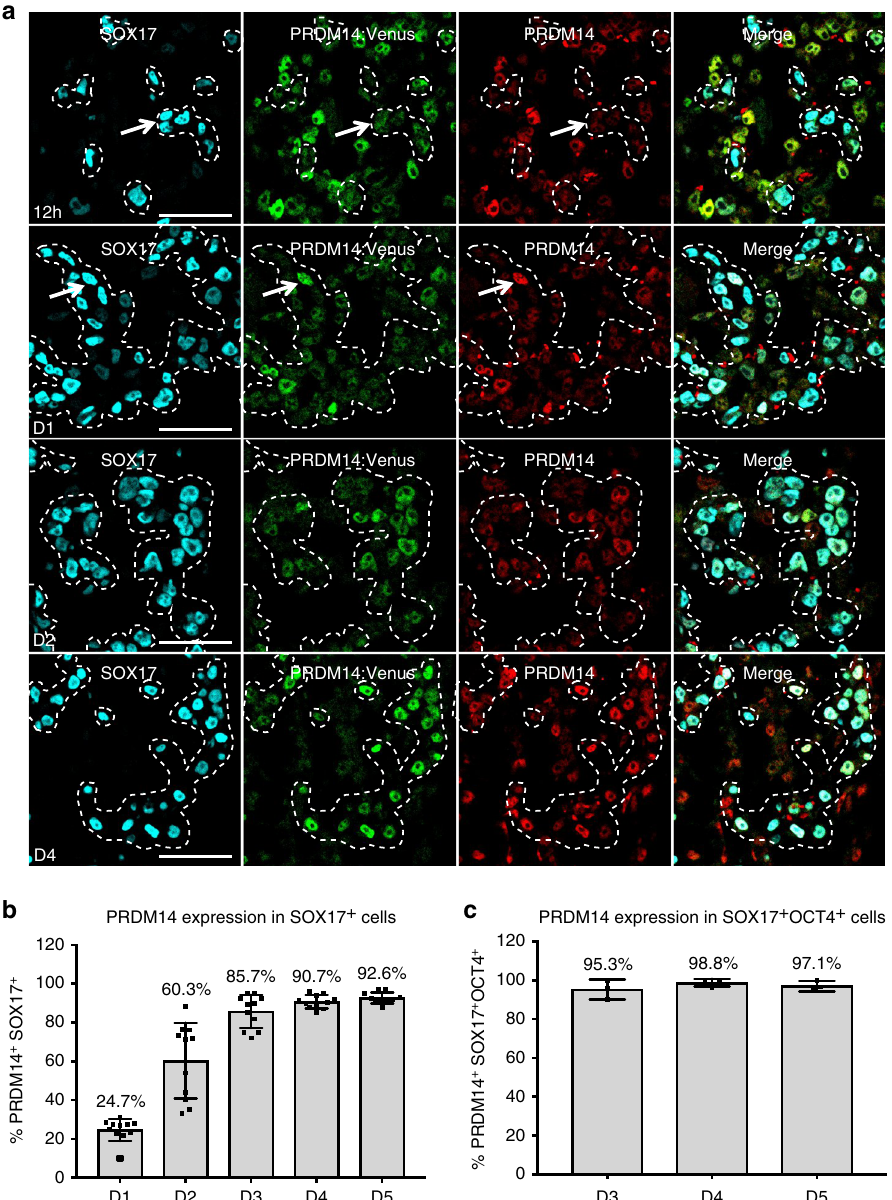
Fig. 2 PRDM14-Venus knock-in reporter detects the dynamics of speci fi c PRDM14 expression in hPGCLCs. a Time-course IF analysis (representative of two hPGCLC inductions) showing PRDM14 expression in embryoid body (EB) sections throughout hPGCLC speci fi cation from PRDM14-AID-Venus fusion reporter cell line. hPGCLCs were induced by cytokines and EBs were collected at 12 h, and on D1-D5. Representative images for 12 h, D1, D2 and D4 are shown. hPGCLCs were marked by SOX17 and highlighted by a dashed line. Arrows show examples of SOX17 + cells that are PRDM14-negative at 12 h and PRDM14-positive on D1 of differentiation. Scale bar is 60 μ m. b Quanti fi cation of results from a and Supplementary Fig. 2A, including the D1 – D5 time points. Data show the percentage of PRDM14-Venus + SOX17 + cells as mean ± SD of n = 11 EB sections from two hPGCLC inductions. c Quanti fi cation of results from (Supplementary Fig. 2A) showing the percentage of PRDM14-Venus + SOX17 + OCT4 + cells as mean ± SD of n = 3 EB sections from one hPGCLC